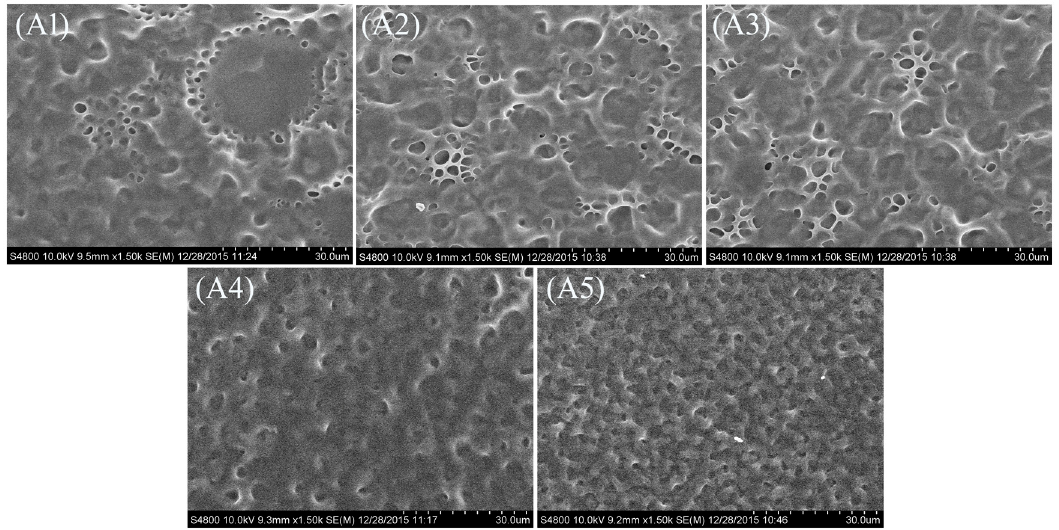
Figure 2. SEM micrographs of the polymer networks of the samples A1 – A5.